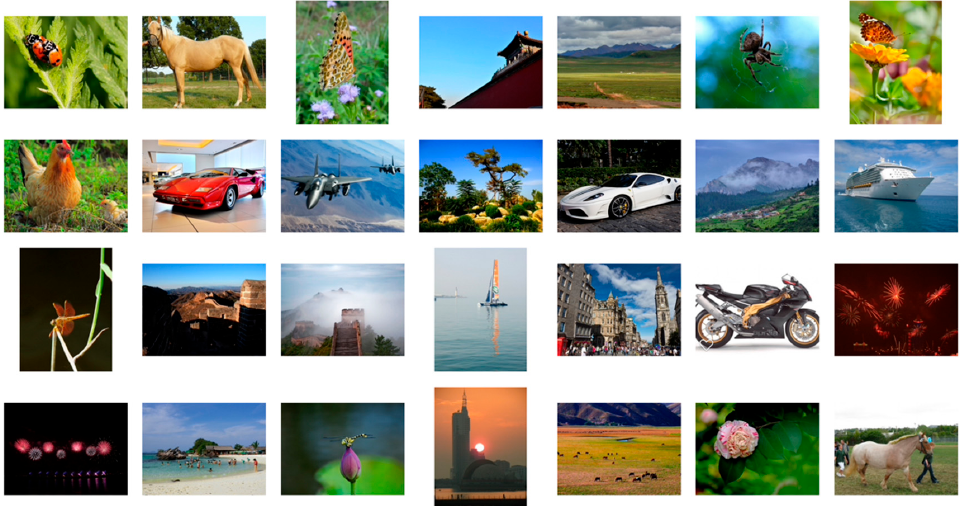
Figure 7. Illustration of the GHIM-10k dataset. Table 1. Results of classification in precision.